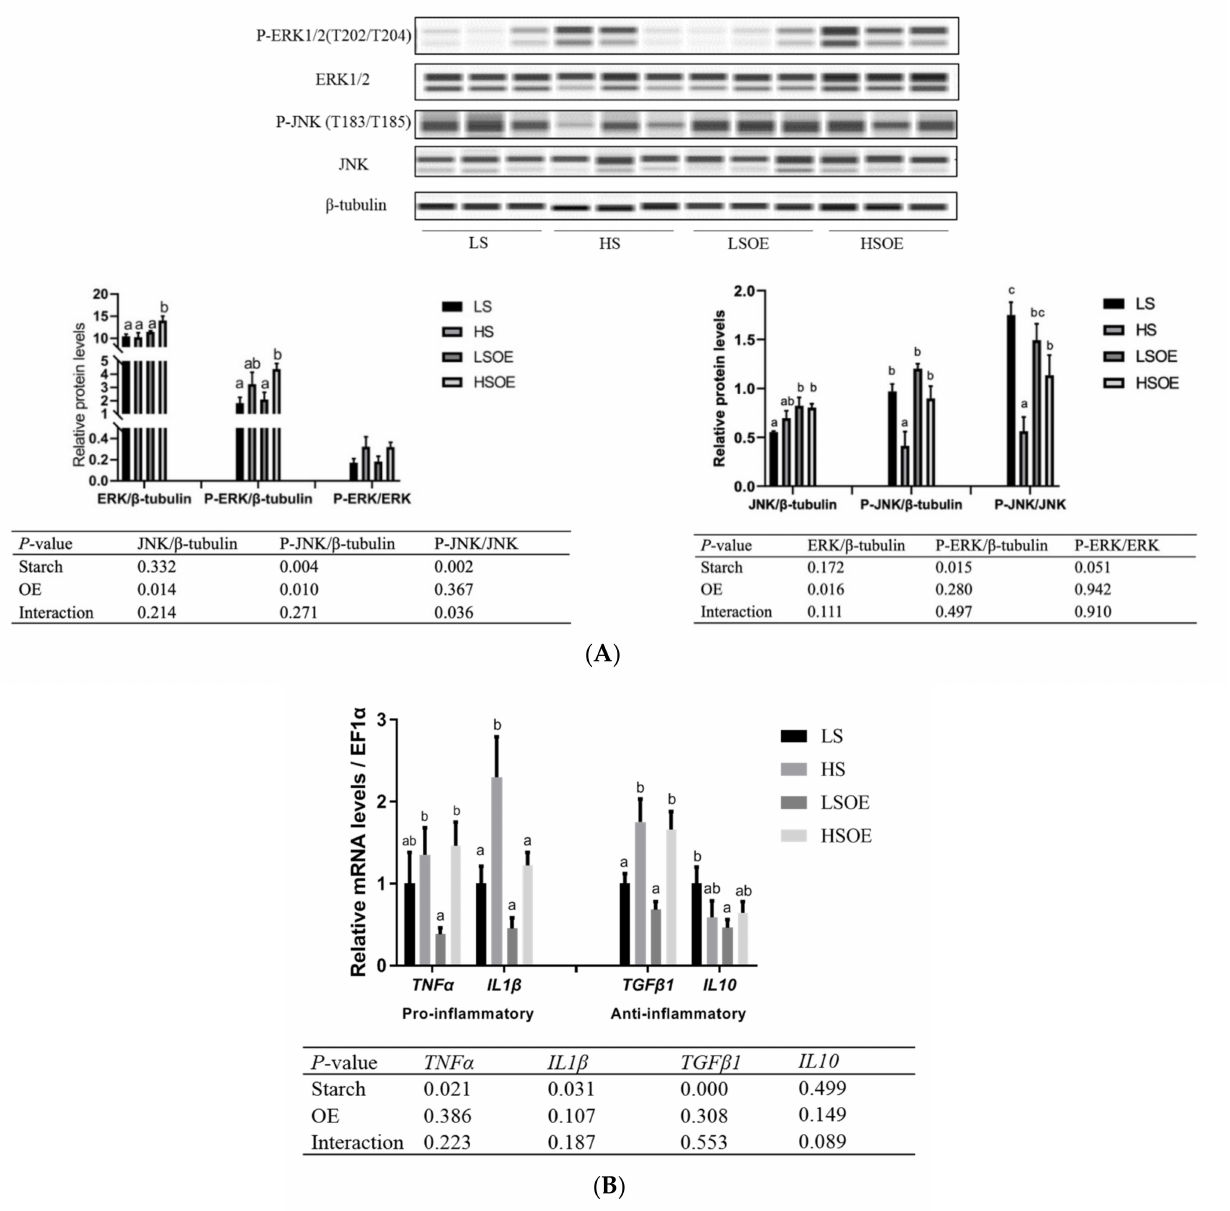
Figure 2. Effects of different diets on hepatic proliferation and inflammatory responses of largemouth bass, ( A ) Western blot of P-ERK, ERK, P-JNK and JNK in the liver (n = 3). ( B ) Effects of different diets on the transcriptional levels of hepatic pro- and anti-inflammation-related genes (n = 8). Both one-way ANOVA and two-way ANOVA statistics were analyzed. Differences were regarded as significant when p < 0.05 (n = 8). Values marked with “a, b and c” are significantly different according to one-way